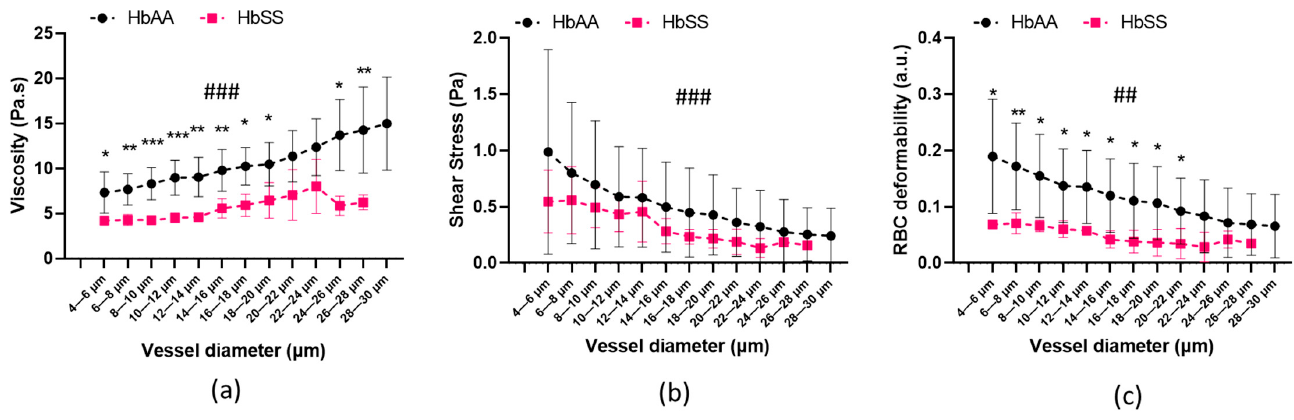
Figure 2. ( a ) Local viscosity in sublingual microcirculation, ( b ) local shear stress in sublingual microcirculation, ( c ) RBC deformability (EI) distribution in sublingual microcirculation in HbAA and HbSS individuals. Significant differences between HbSS and HbAA groups: * represents p < 0.05, ** represents p < 0.01, and *** represents p < 0.001. Significant changes in microcirculation (over vessel diameters): ## represents p < 0.01, and ### represents p < 0.001.